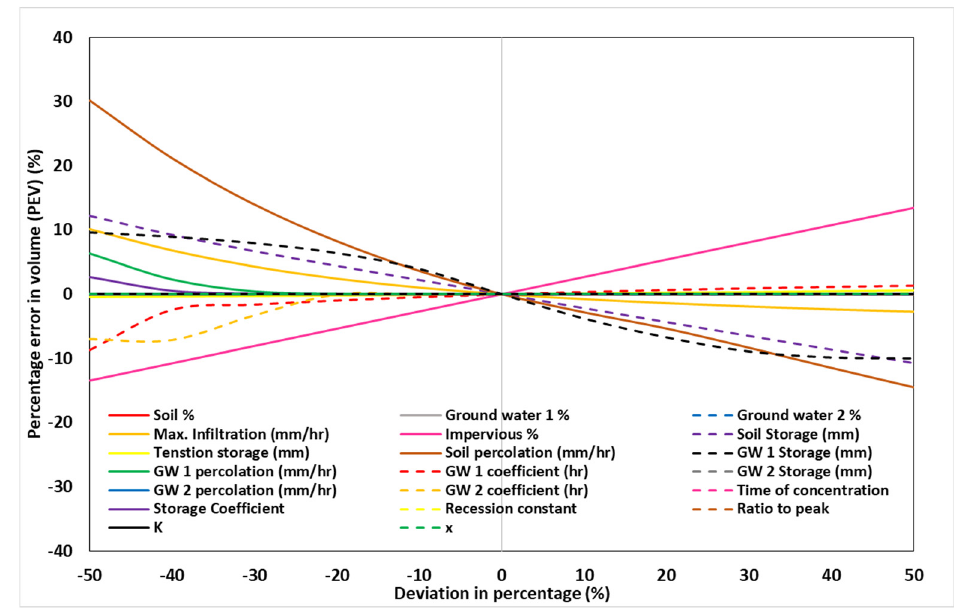
Figure 3. Sensitivity analysis of the HEC-HMS model for the calibration period (2007-2010).